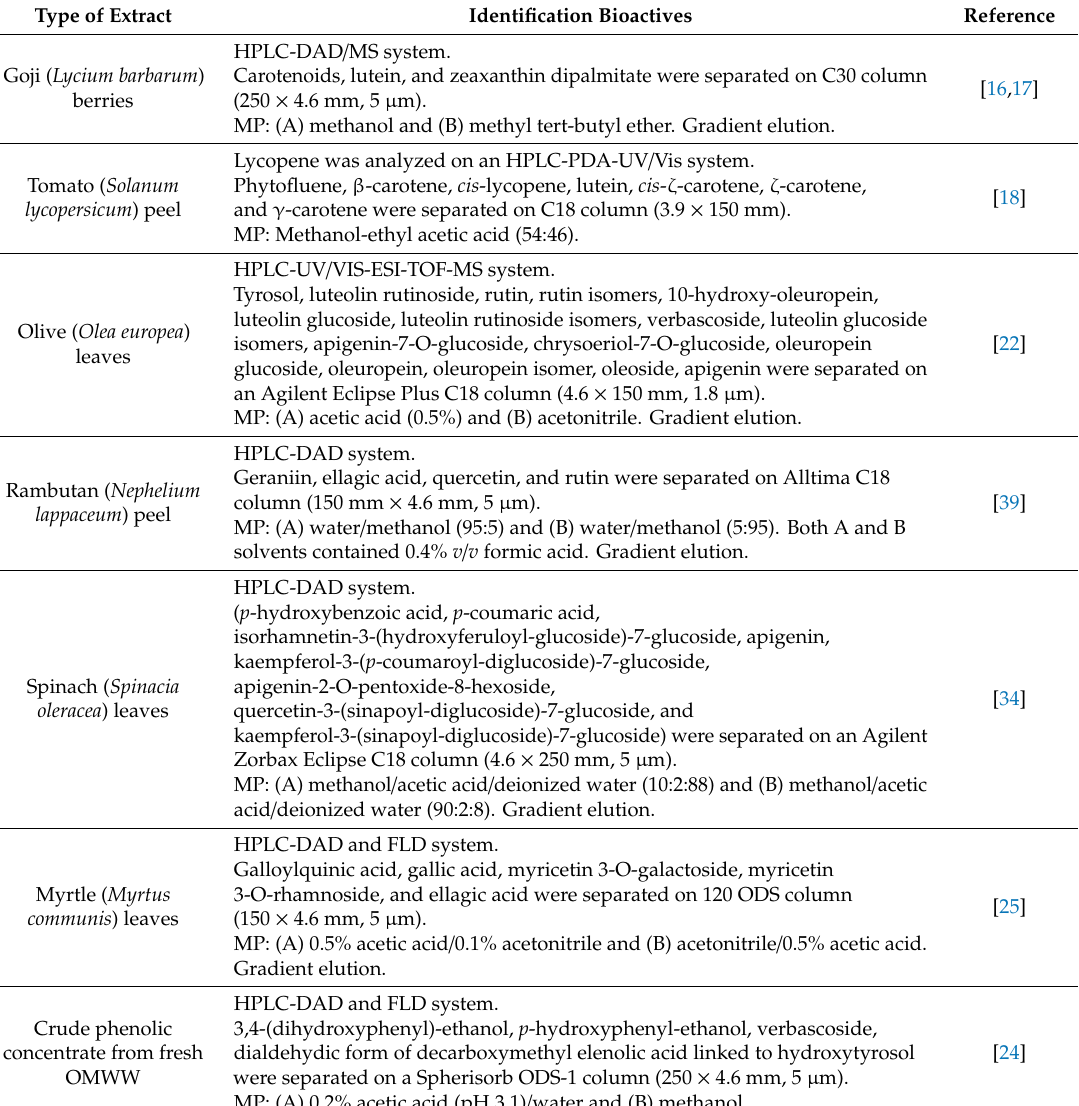
Table 2. Examples of some extracts added to oils, together with the identification of the bioactives. Type of Extract Identification